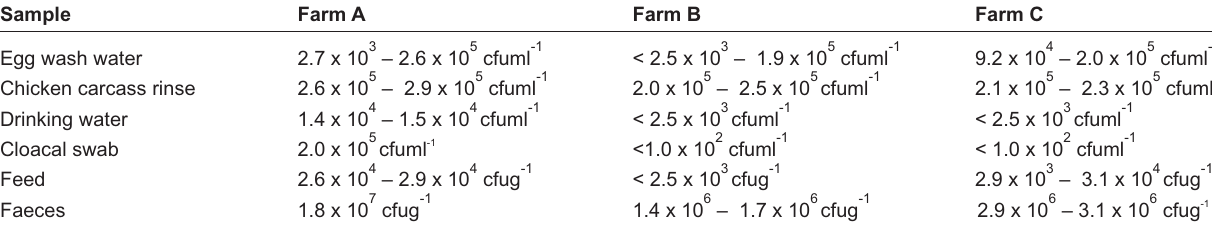
Table-1: Total plate count of bacteria observed in culled chicken layers